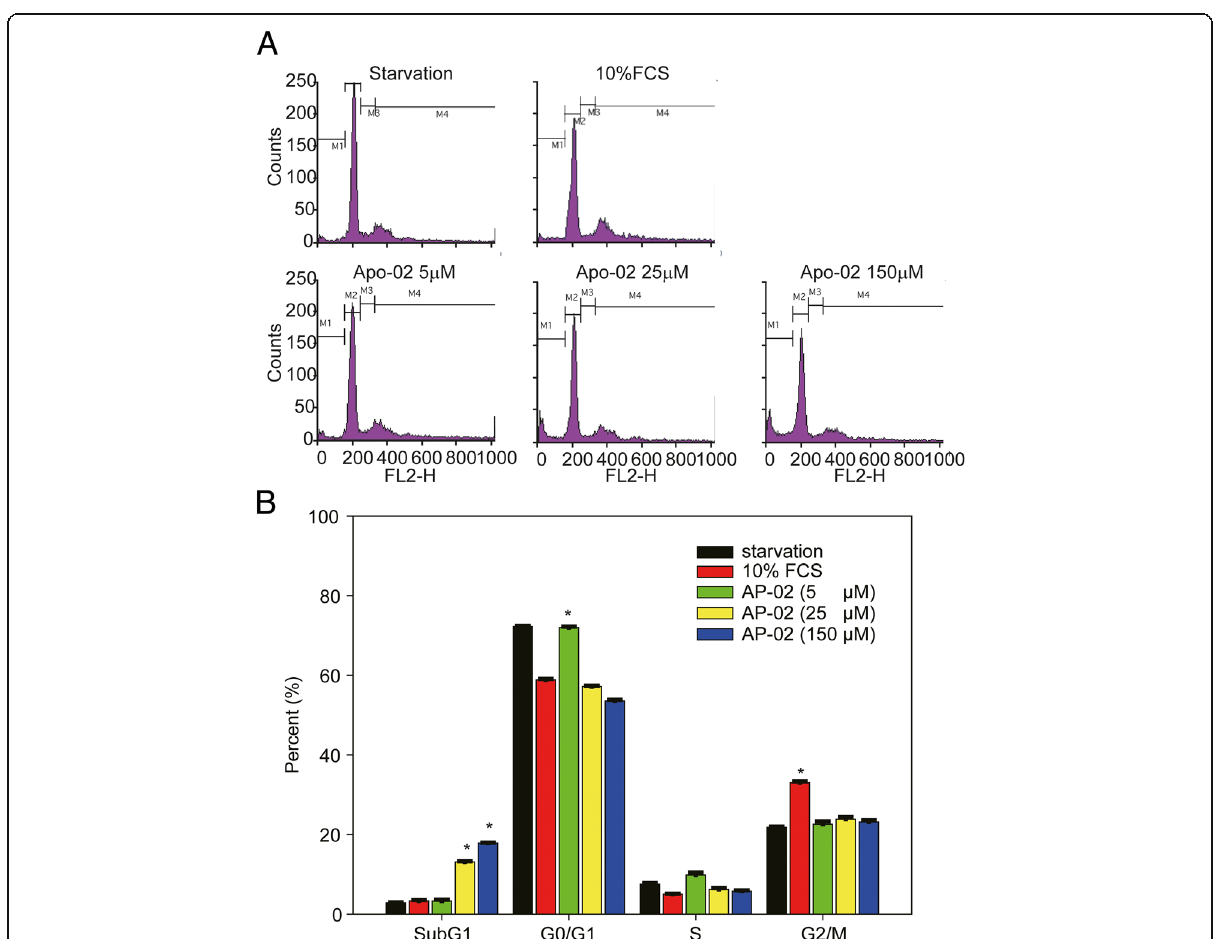
Fig. 5 AP-02 induces G0/G1 phase cell cycle arrest and apoptosis in COLO 205 human cancer cells. a Before cell cycle experiments, COLO 205 cells were synchronized using 0.04% FCS for 24 h as described in Materials and Methods (upper left). After serum starvation, synchronized cells were replenished with complete medium (10% FCS) containing PBS (upper right) or 5, 25, or 150 μ M AP-02 in PBS (lower panel). FACS analysis of DNA content 15 h after release from quiescence through incubation in culture medium supplemented with 10% FCS and various concentrations of AP-02 in PBS. b Percentages of cells in the sub-G1, G0/G1, S, and G2/M cell cycle phases were determined using CellFIT DNA analysis software. Three samples were analyzed in each group, and values represent the mean ±